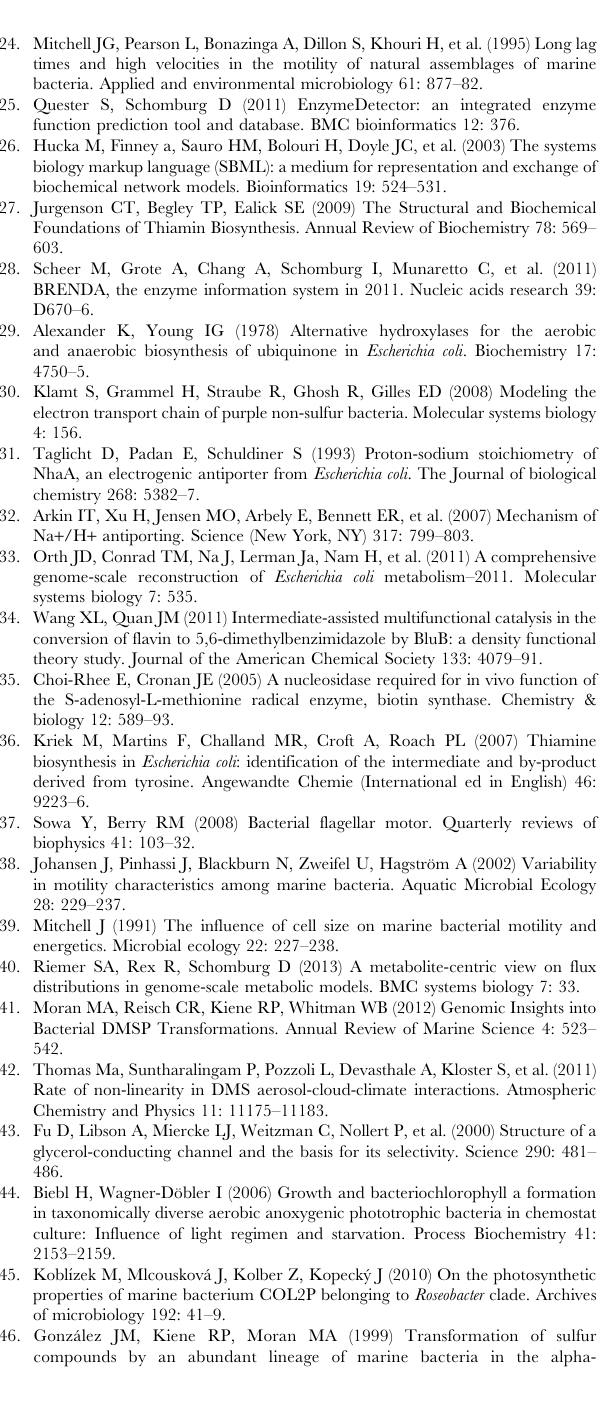
Figure S1 Graphical representation of the distribution of evidence